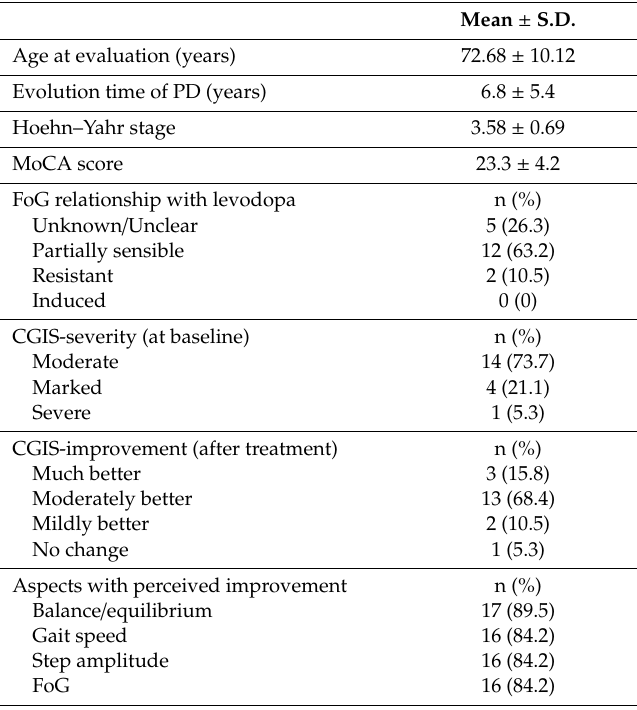
Table 1. Summary of clinical features of included patients.